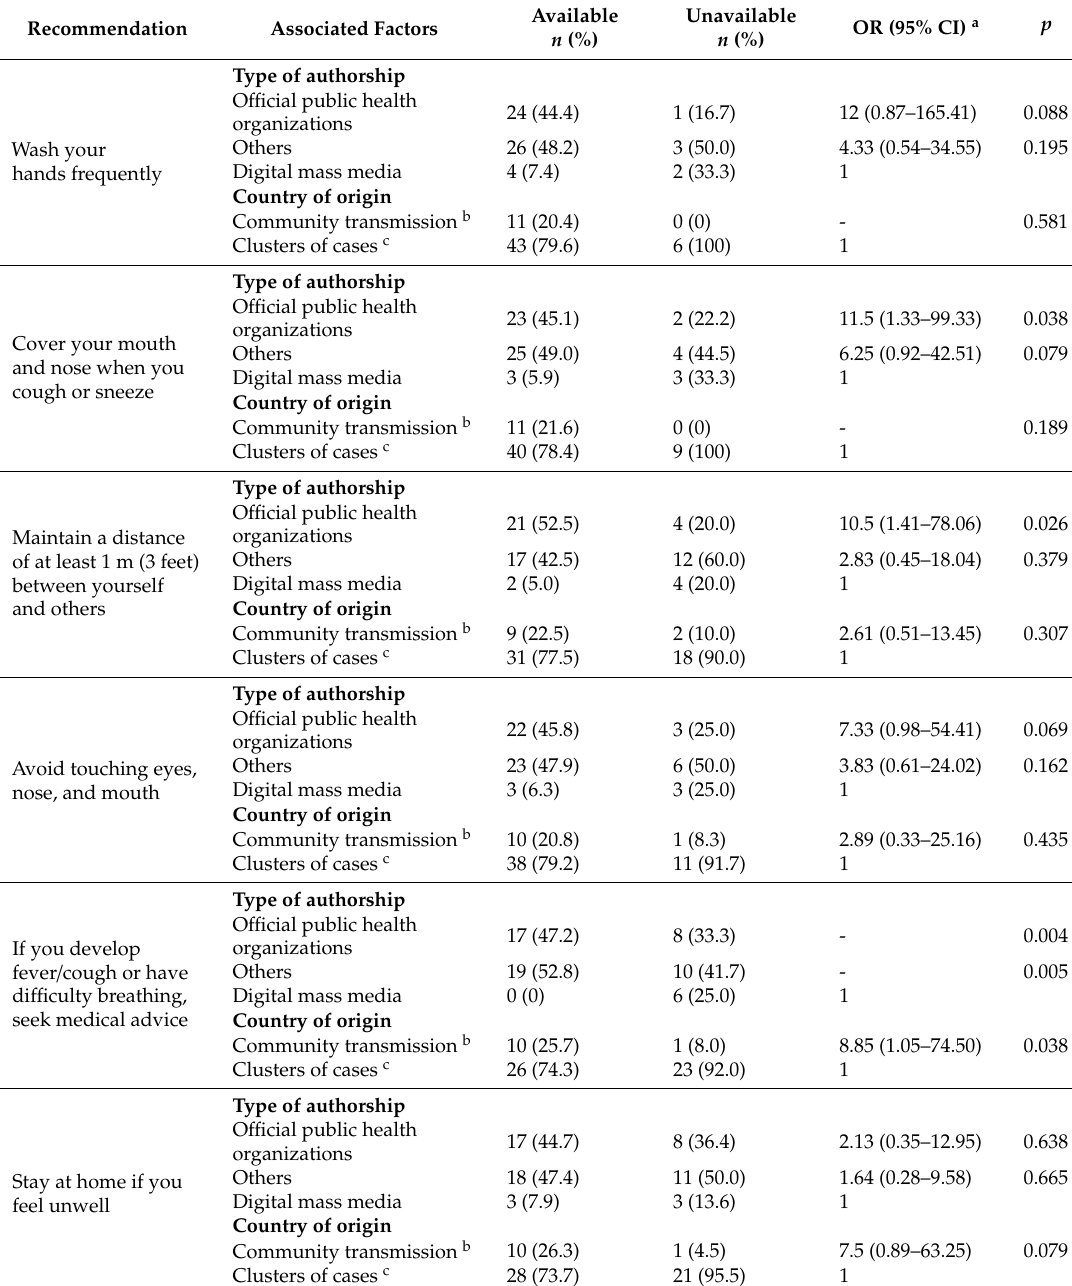
Table 4. Recommendations relating to the prevention of COVID-19 provided by the WHO and available on the Internet, with associated factors, on 13 July 2020.